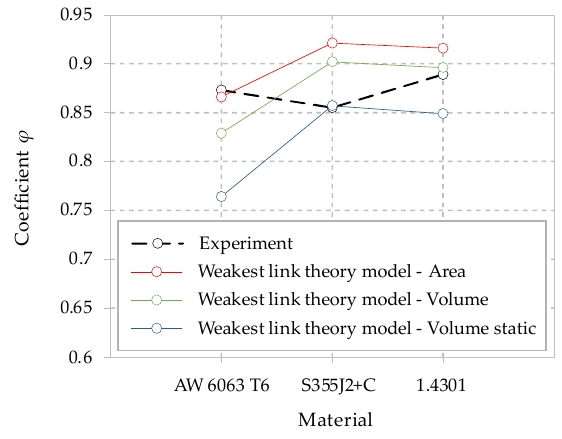
Figure 8. Values of the coefficient φ .